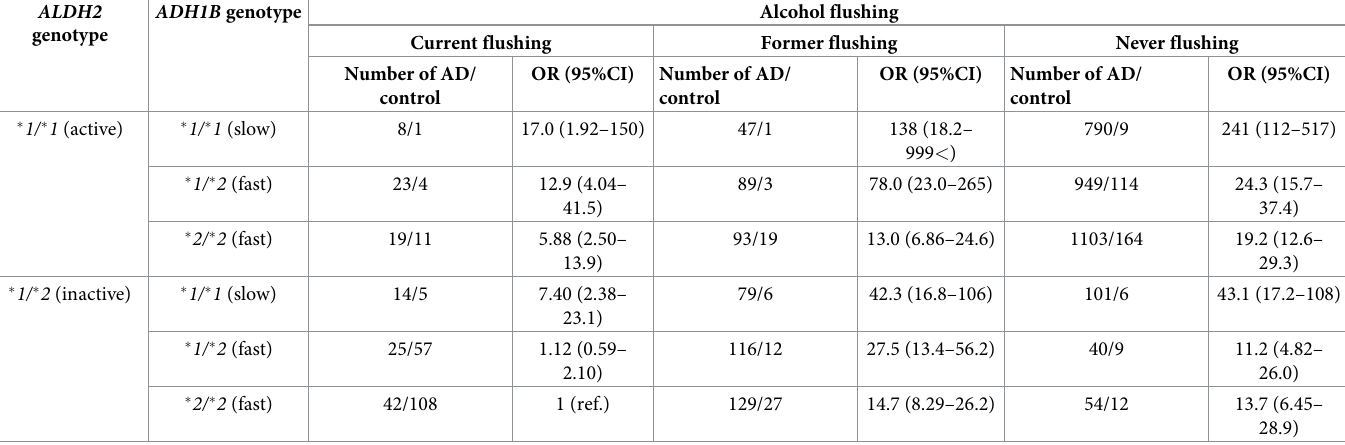
Table 4. Age-adjusted odds ratios (95% confidence intervals) of alcohol dependence according to the combinations of alcohol flushing status and ALDH2 and ADH1B genotypes in the male subjects.